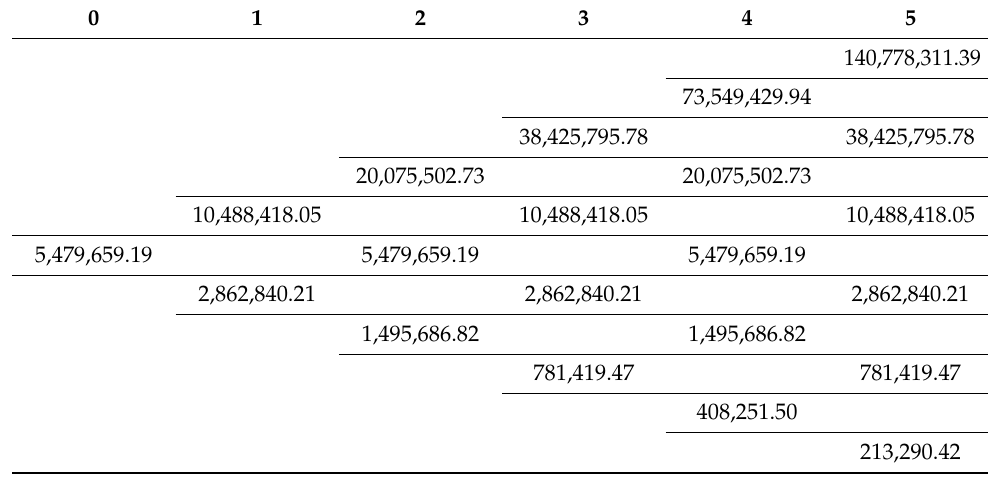
Table 5. Net Present Value binomial tree ( € ).